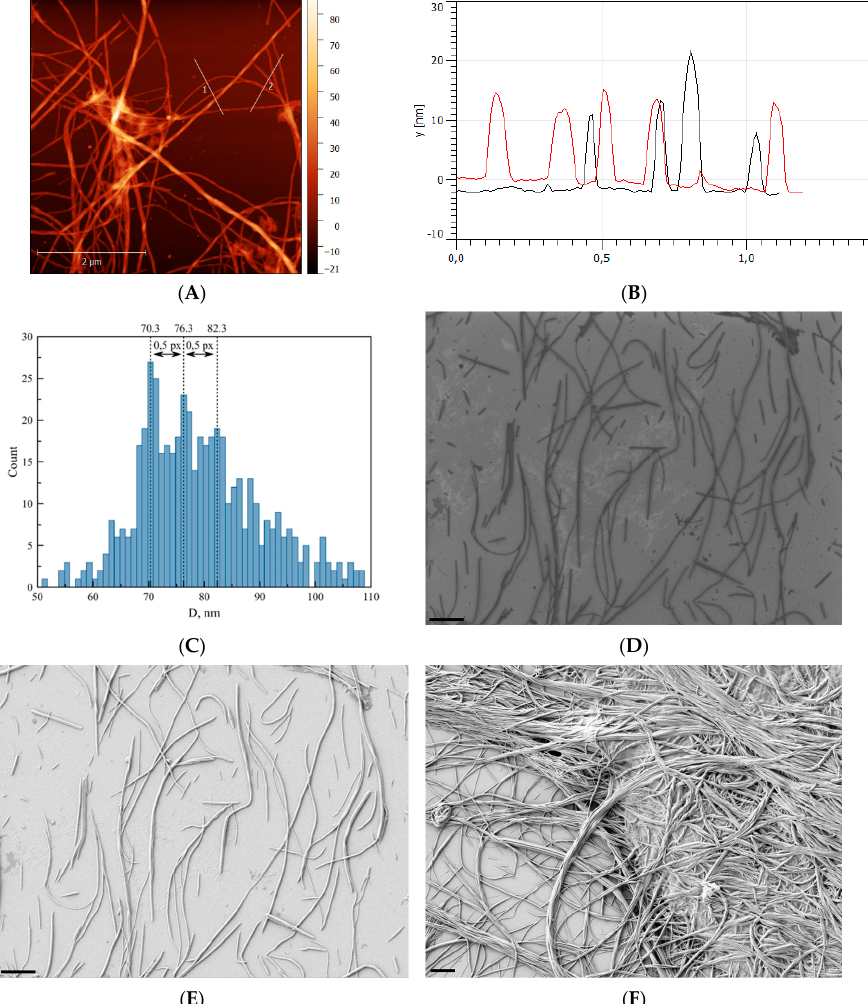
Figure 10. ( A , B ) AFM results; and ( D – F ) SEM images of fibrils after silver reduction in solution with DNA–Ag–Phen complexes ( C (DNA) = 0.005%, C (Ag–Phen) = C (NaBH 4 ) = 4.5 × 10 − 4 M in 0.005 M NaNO 3 ). After fixation on: mica ( A ); and silicon ( D – F ) surfaces. Image ( D ) is obtained by InLens detector, image ( E ) by SE2. The scale bar is 1 μ m. Diagram ( C ) shows the distribution of diameters of fibrils on image ( E ) (five different images).